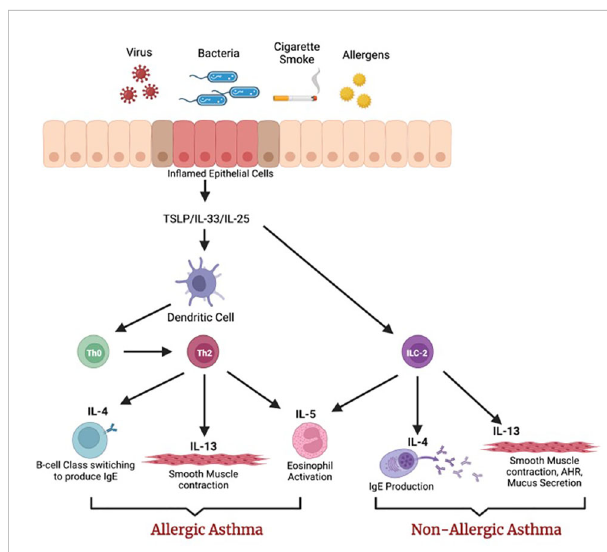
FIGURE 2 The role of the alarmins in the lung epithelium. Exposure to allergens, viruses, and bacteria releases cytokines from the lung epithelium that can activate dendritic cells (DC) and innate lymphoid cells (ILC-2) that belong to the innate immune system. DCs differentiate naïve T cells into Th2 cells that can secrete IL-4, IL-13, and IL-5. These cytokines play a role in airway remodeling. Similarly, ILC-2s secrete Th2 cytokines. Image created with